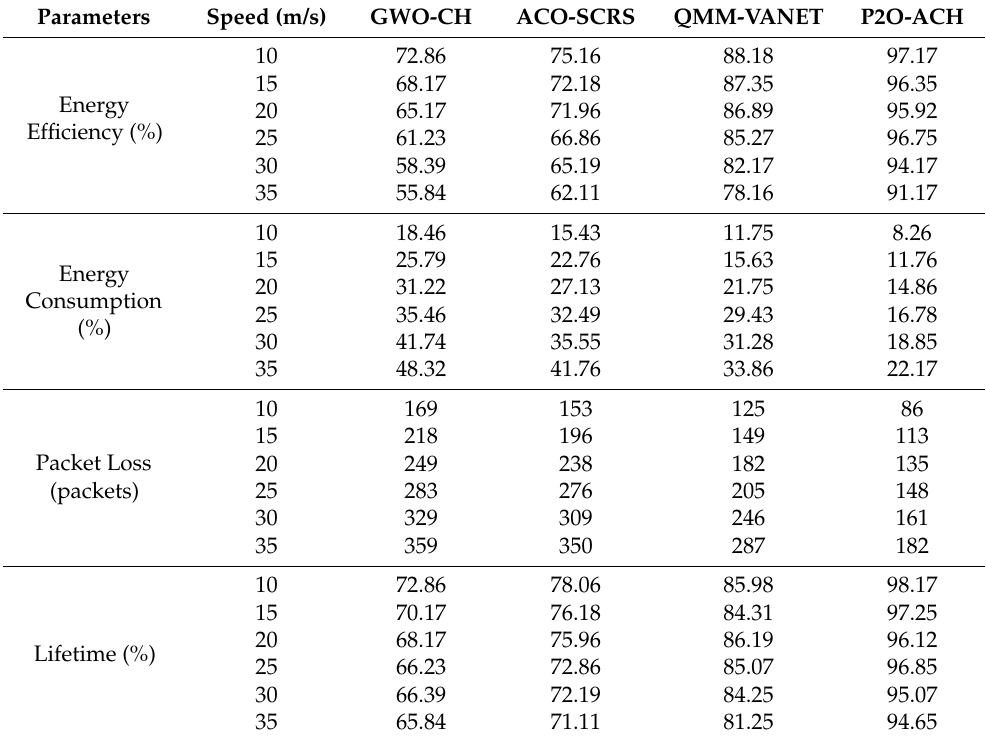
Table 9. Performance Analysis of Energy Efficiency, Energy Consumption, Packet Loss, and Network Lifetime in Terms of Varying